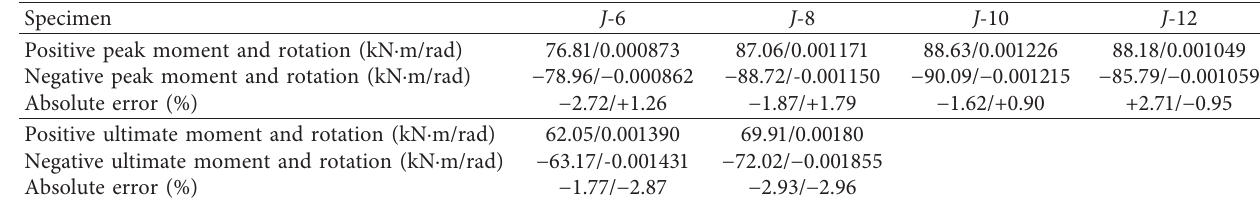
Table 4: The comparison of maximum and minimum moment and rotation.